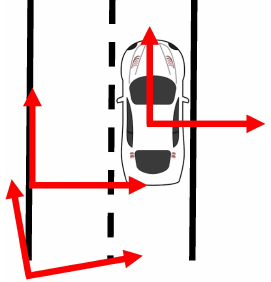
Figure 1. The platform, road and global coordinate systems are schematically demonstrated by red